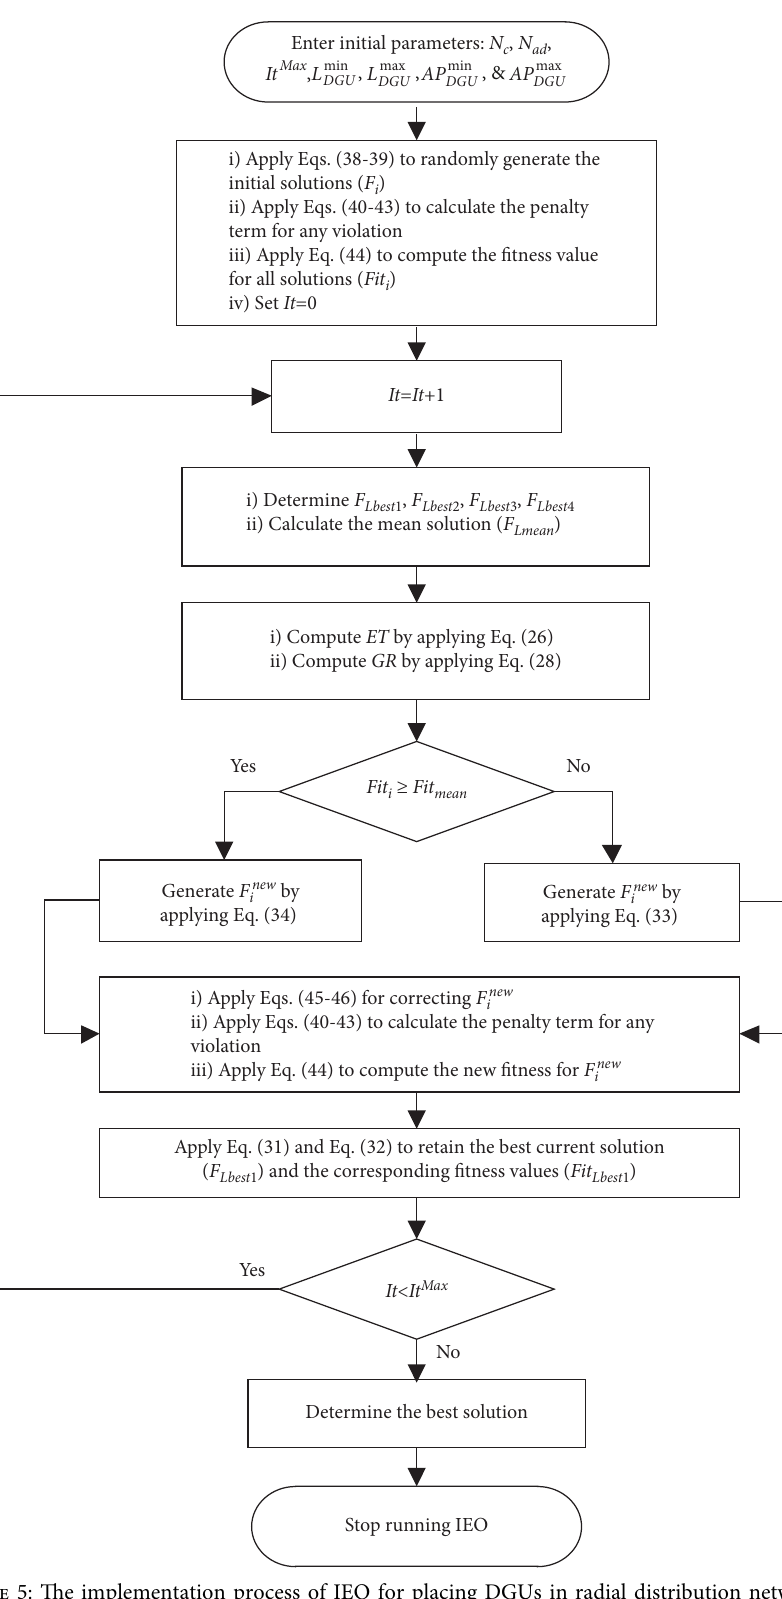
Figure 5: Te implementation process of IEO for placing DGUs in radial distribution